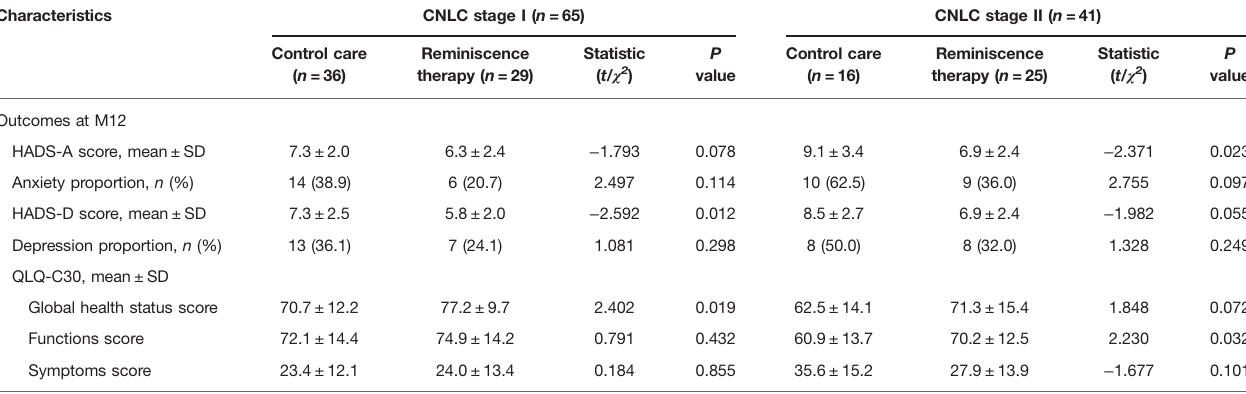
TABLE 3 | Subgroup analyses by CNLC stage.